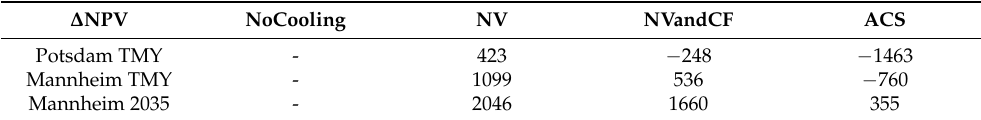
Table 16. ∆ NPV for different climates and cooling concepts.